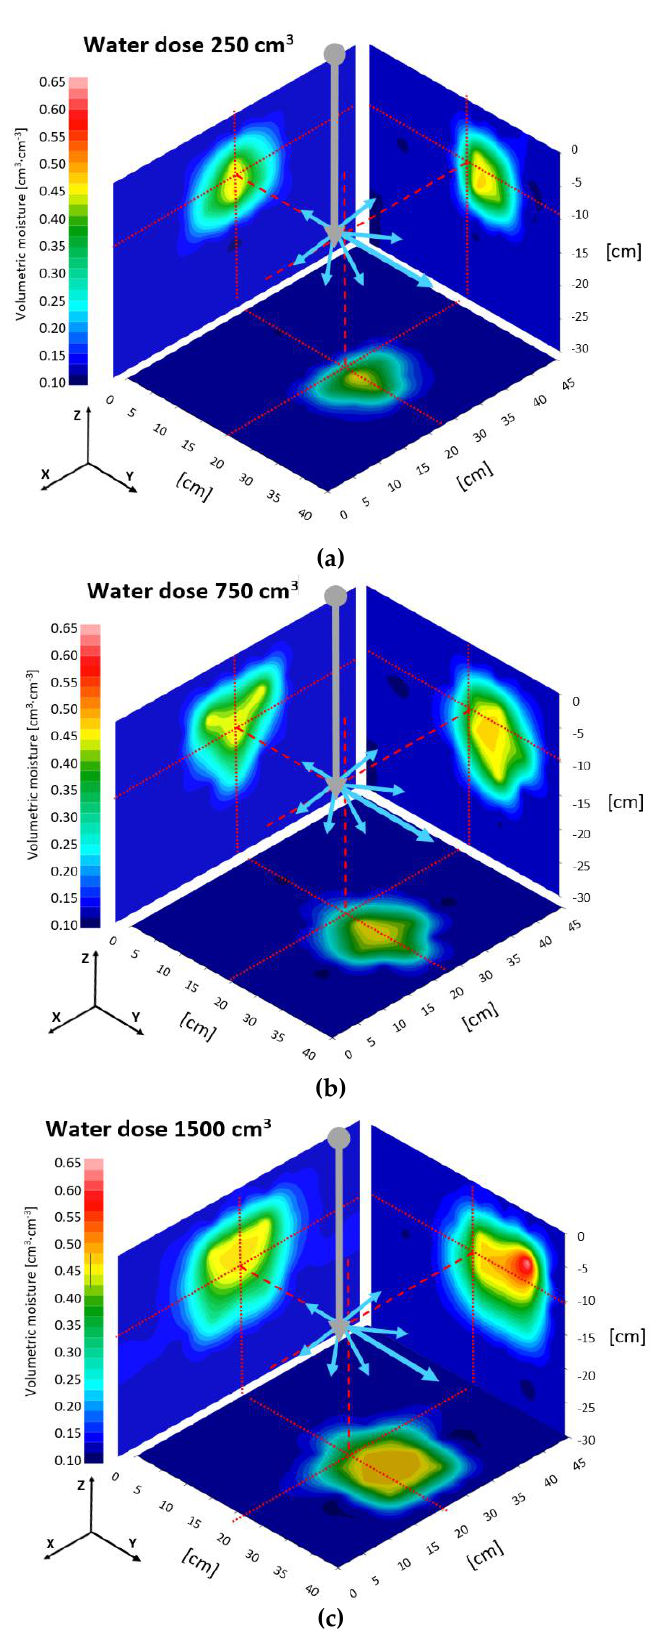
Figure 7. Distributions of moisture in selected sections for doses of 250 ( a ), 750 ( b ), and 1500 ( c ) cm 3 .